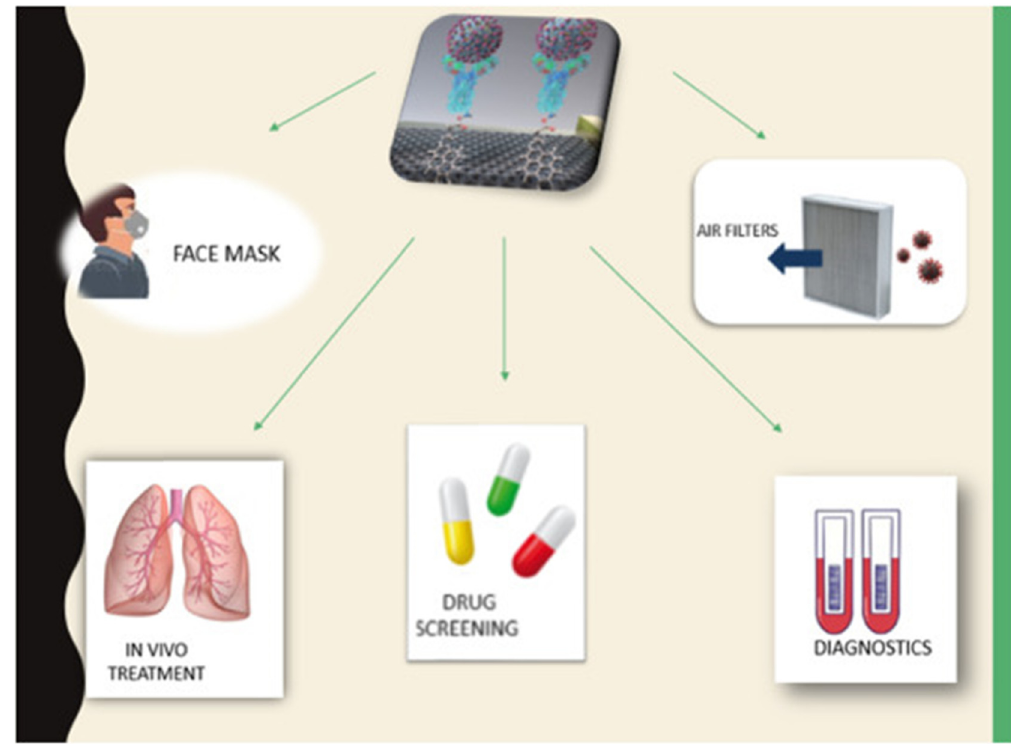
Figure 8: Di ff erent ways of using nanosensors ( graphene ) [ 83 ] .